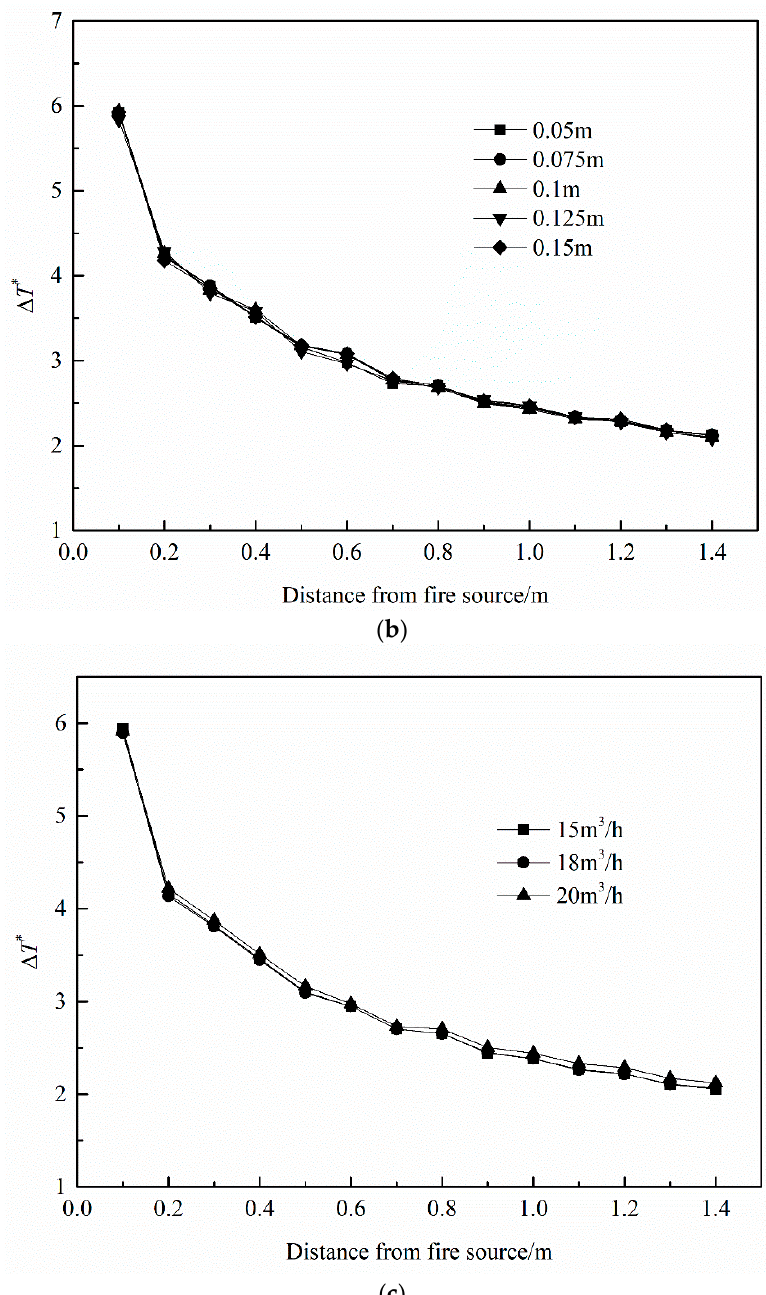
Figure 8. Effects of ( a ) distance between two extraction vents, ( b ) extraction vent length and ( c ) exhaust volumetric flow rate on the dimensionless smoke temperature rise.